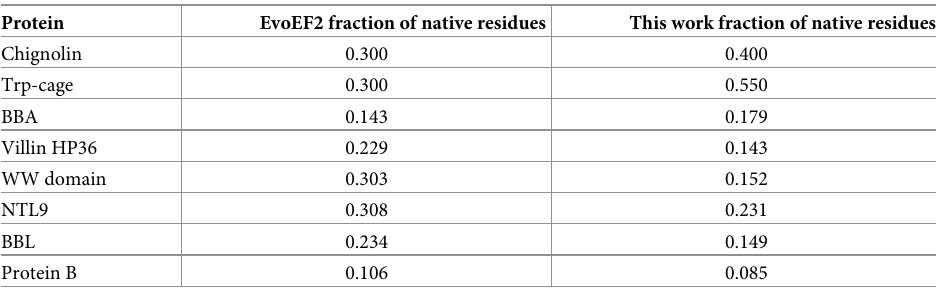
Table 1. Fixed backbone